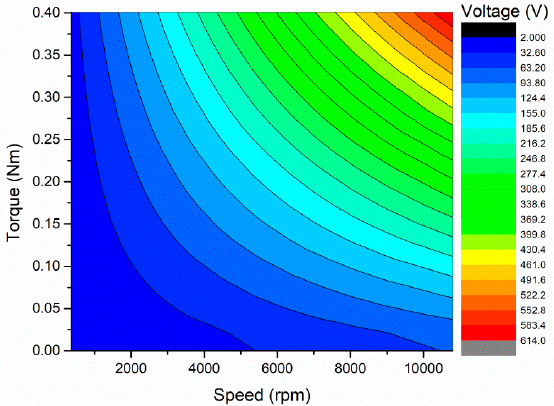
Figure 12. DC voltage of FRCPM with the variation of torque and speed.